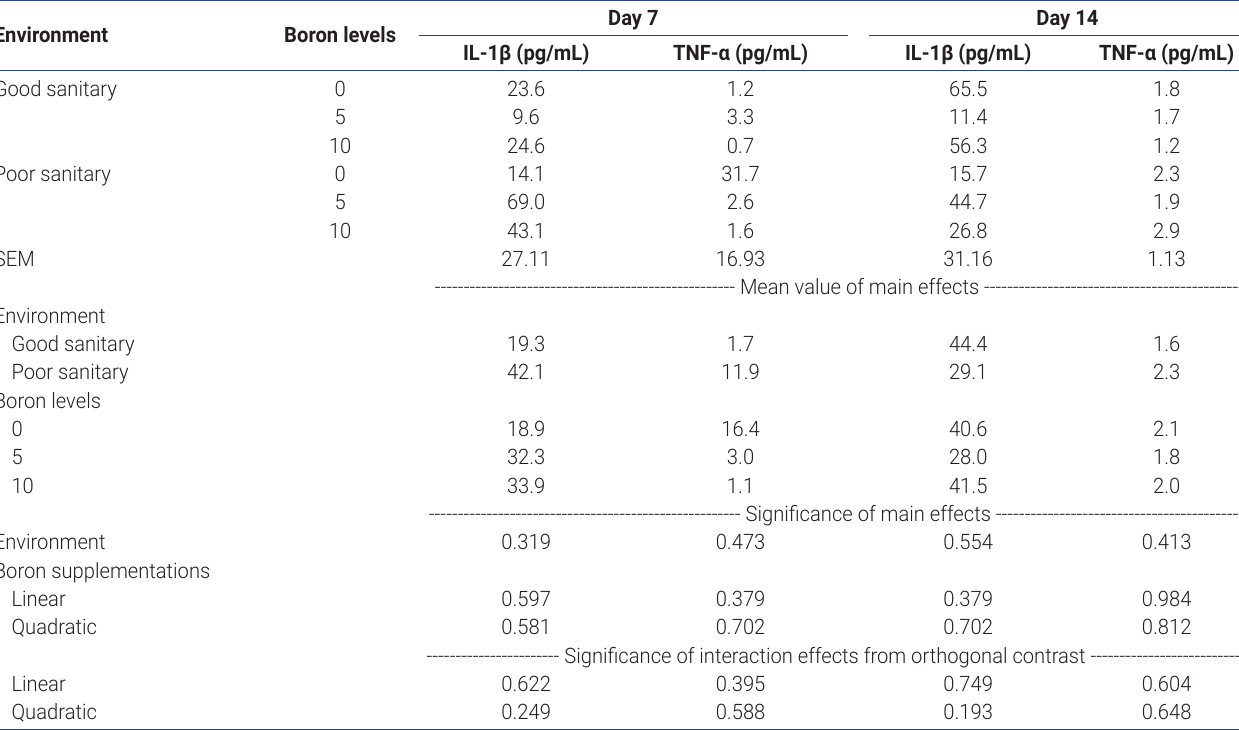
Table 5. Effects of environment and boron levels (mg/kg) on pro-inflammatory cytokines of gut mucosa in weaned pigs on days 7 and 14